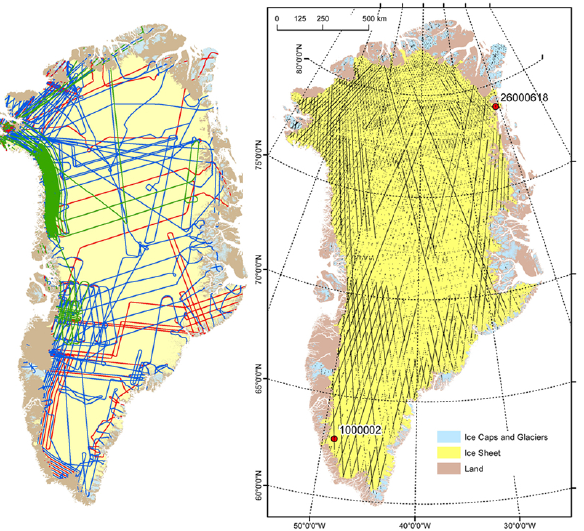
Figure 4. Left panel: ATM (2013, red lines; 2014, blue lines) and LVIS (2013, green lines) trajectories over the Greenland Ice Sheet (yellow) and local ice glaciers and peripheral ice caps (blue). Ice sheet, ice caps and glacier boundaries are from Rastner et al., 2012. Ice sheet is shown in yellow and local glaciers and ice caps are blue. Right panel: location of SERAC times series (black dots) generated from the combined 1993-2014 ICESat, ATM and LVIS data sets.